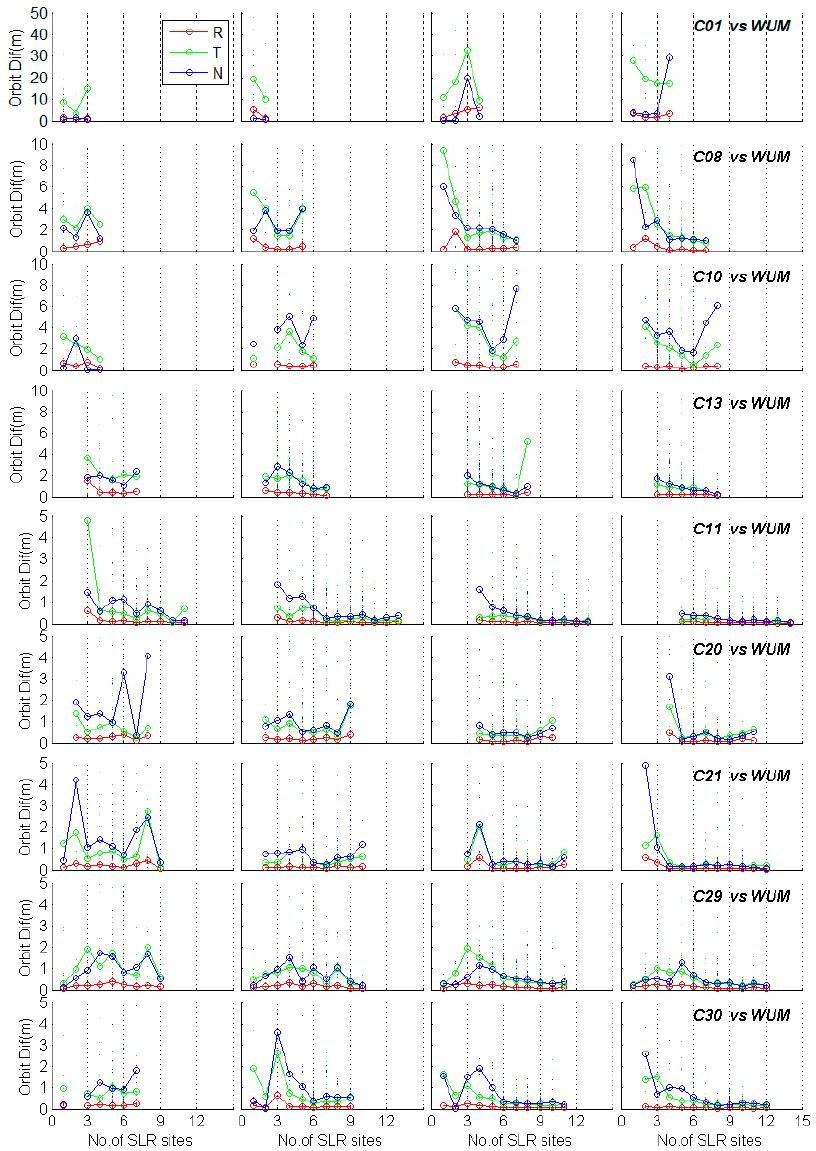
Figure 17. The dependency of median RMS on the number of SLR sites. The definition of different colour dots and circles are the same as in Figure 16.